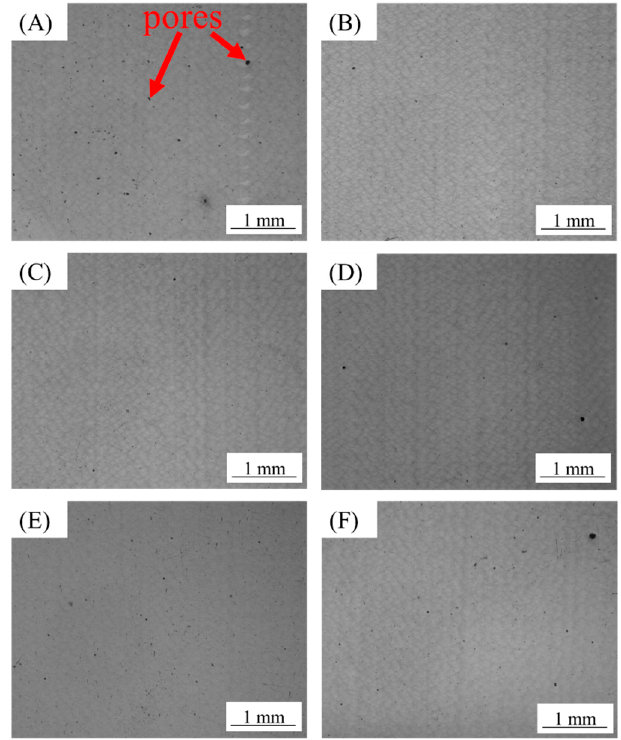
Figure 5. Optical micrographs of AlSi10Mg fabricated with hatch spacing of 0.16 mm and at different volume energy density, showing variation in porosity: ( A ) Process A1; ( B ) Process A2; ( C ) Process A3; ( D ) Process A4; ( E ) Process A5; ( F ) Process